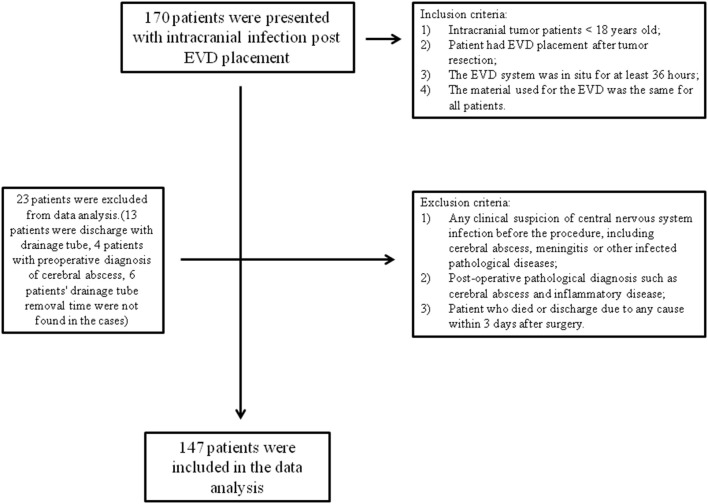
Flow chart of the patients included in this study.